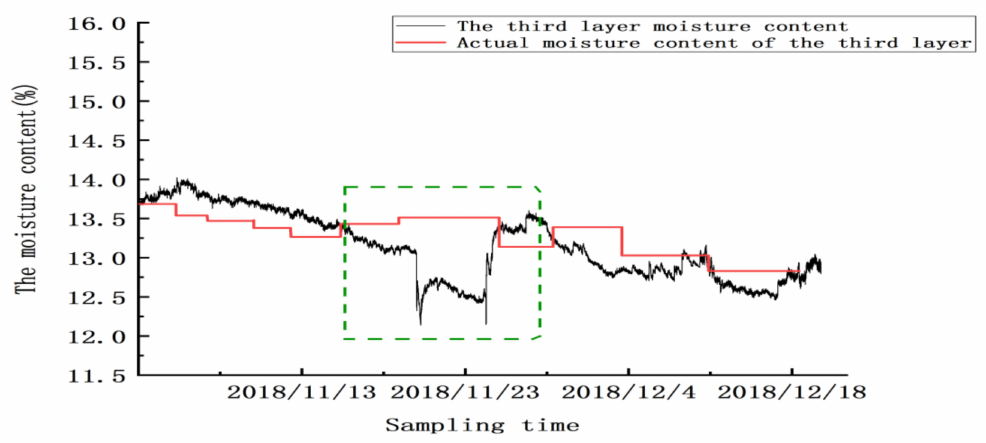
Figure 24. The moisture values of the grain in the third layer.